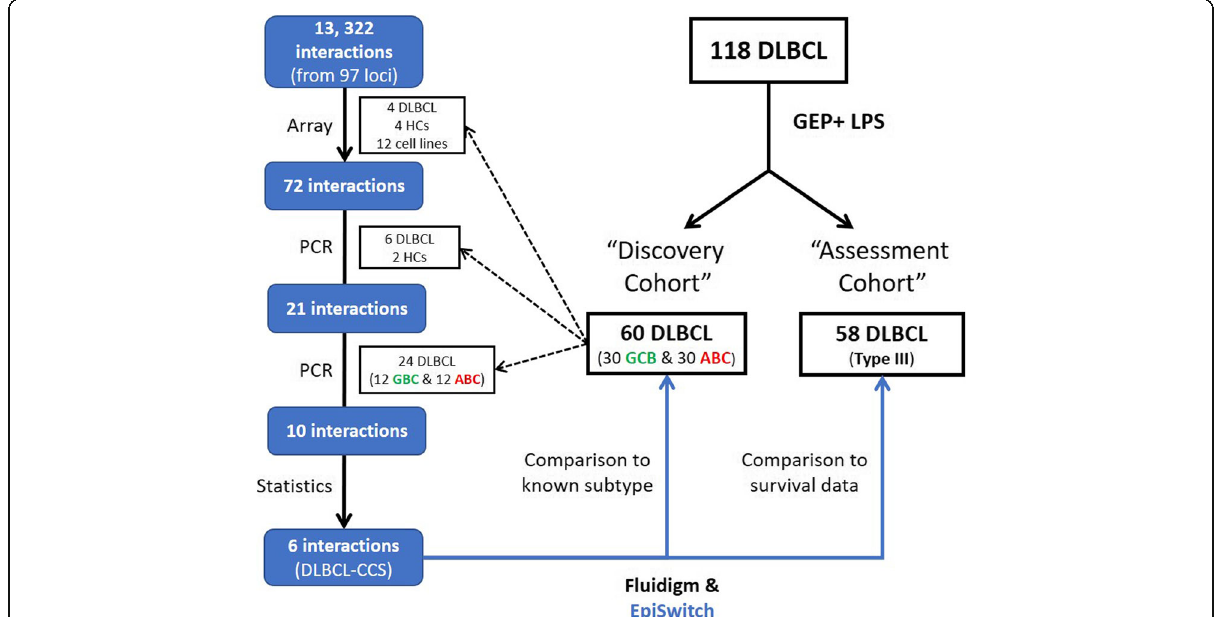
Fig. 1 Workflow used to develop the DLBCL-CCS classifier. The DLBCL-CCS classifier was developed and assessed using a two-pronged, sequential approach. A total of 118 DLBCL samples were classified into disease subtypes (ABC, GBC or Type III using gene expression profiling (GEP) and calculation of an LPS. Samples of known subtypes (30 samples on either end of the LPS spectrum) were used to identify changes in genomic architecture at six genomic loci that could best discriminate between ABC and GCB subtypes (the EpiSwitch DLBCL-CCS). 58 samples with intermediate LPS scores (Type III) were used to assess the performance of the EpiSwitch DLBCL-CCS and the Fluidigm